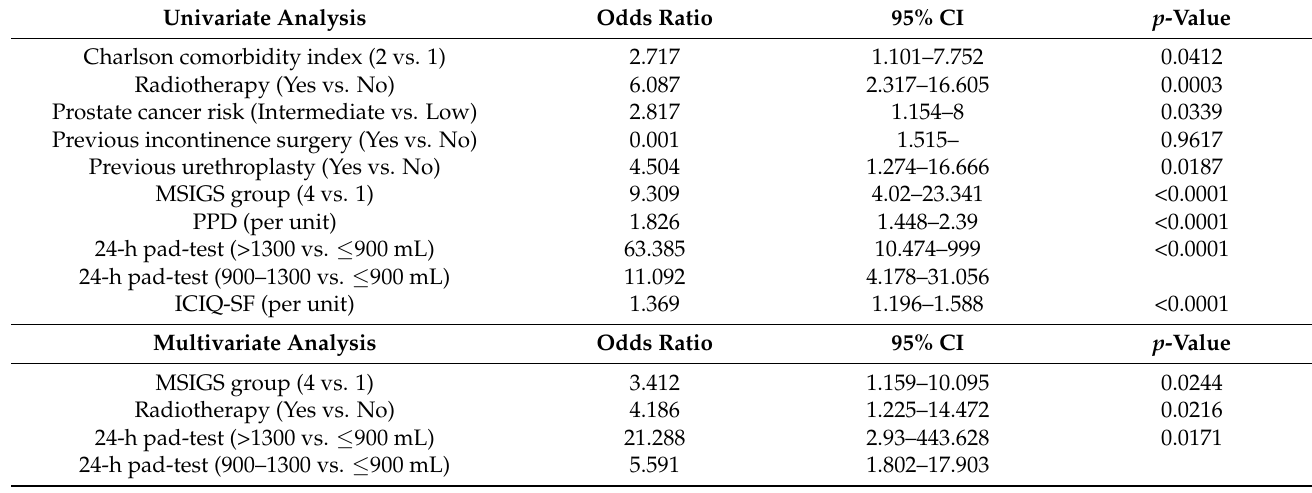
Table 3. Logistic regression model to predict ATOMS